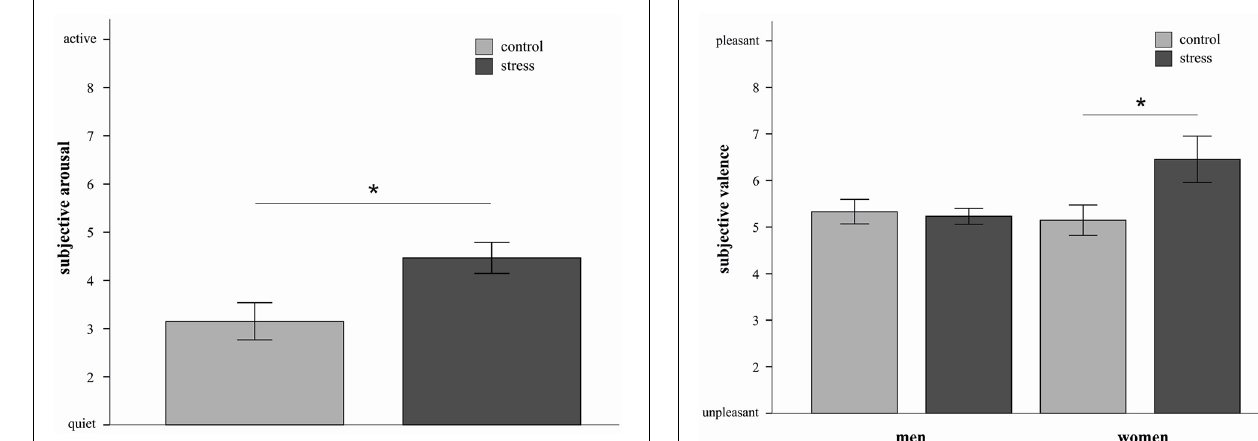
four way interaction [stress by sex by strategy by valence ( p